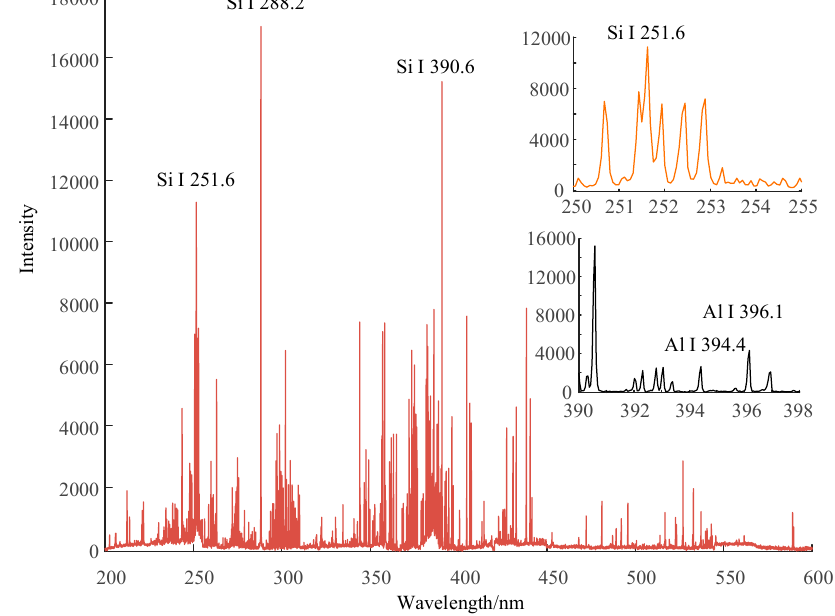
Figure 6. Emission spectrum of new HTV silicone rubber with no additional ATH and silica filler.